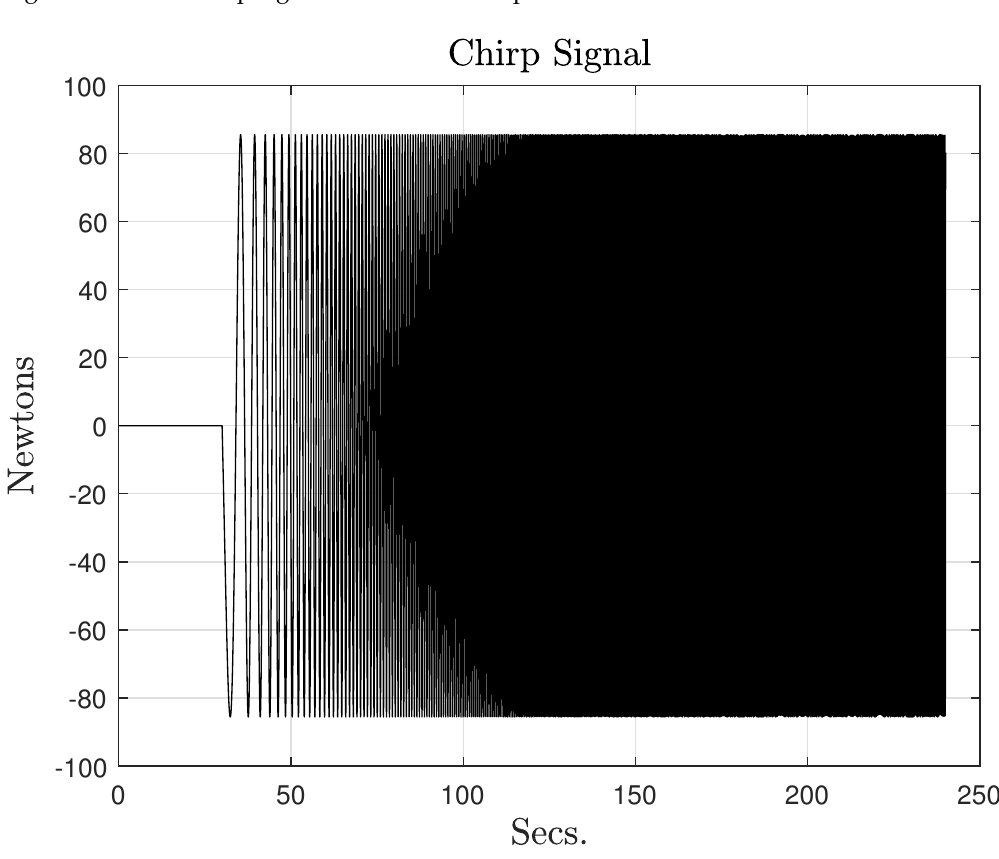
Figure 5. Chirp signal with frequency swept from 0.5 to 8 rad/s and 85 N